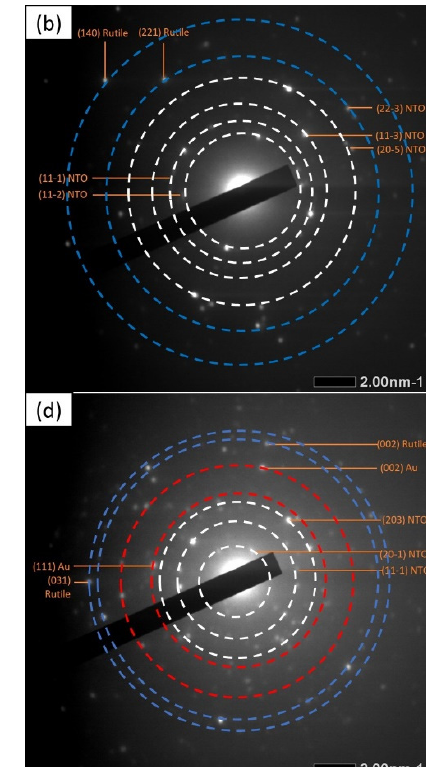
Figure 7. ( a ) Absorption spectrum UV-vis spectroscopy of TiO 2 /NTO with varying Au loading (1, 2, and 3 wt%), and ( b ) Tauc plot obtained through the application of Equation (6) for the samples. The TiO 2 /NTO composites only had ultraviolet light absorption characteristics. How- ever, there was a decrease in the bandgap with the addition of gold composites; this indi- cates that gold provides a change in the electronic state of the composite. The bandgap energy value (Eg) was obtained using the Tauc equation in Equation (7) [55]. ( α h ν ) 1/n = A(h ν − Eg)